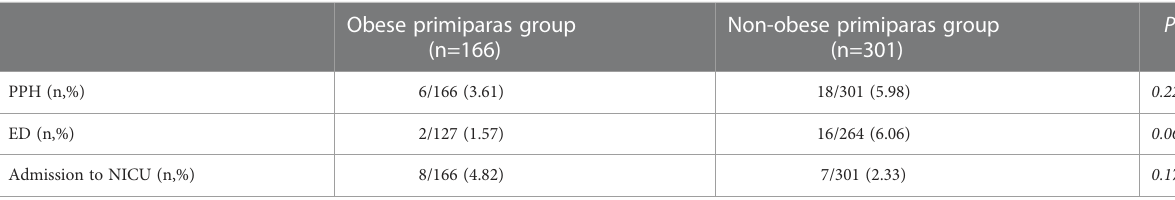
TABLE 3 Adverse maternal and child outcomes of